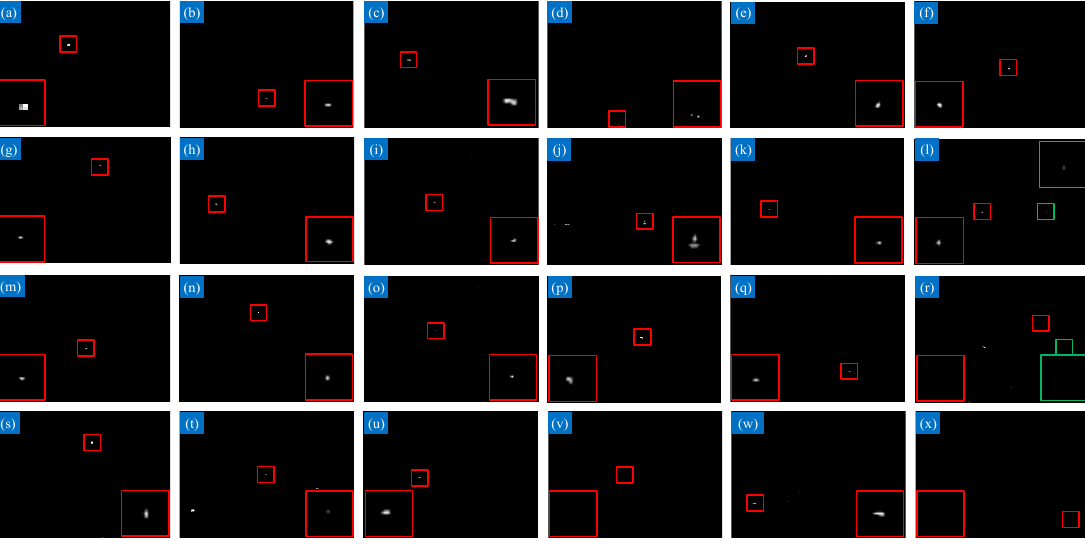
Figure B1. The first and third row show infrared images with additive white Gaussian noise with standard deviation of 10 and 20, and the second and fourth rows are the corresponding detection results by IPI.